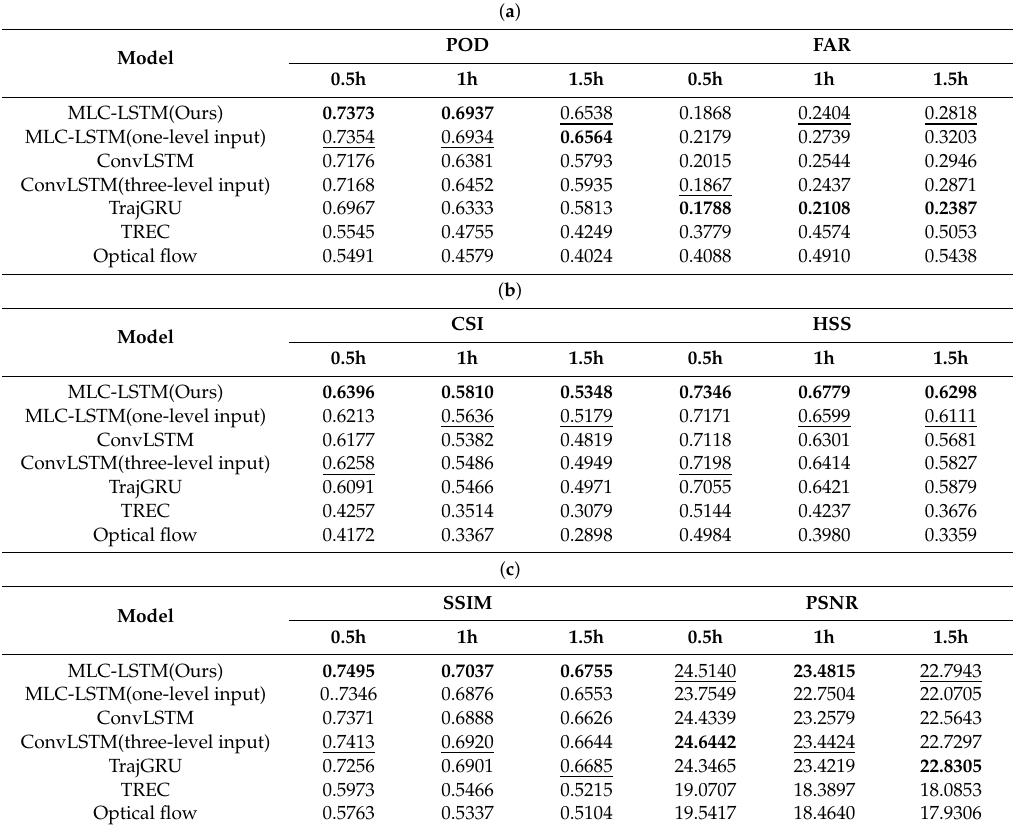
Table 6. Quantitative evaluation results of seven models on six metrics. The mean value of six metrics of 5, 10, and 15 extrapolation steps is reported, respectively (corresponding to 0.5, 1, and 1.5 h). ( a ) Evaluation results on the probability of detection (POD) and false alarm rate (FAR); ( b ) Evaluation results on the critical success index (CSI) and Heidke skill score (HSS); ( c ) Evaluation results on the structural similarity index measure (SSIM) and peak signal to noise ratio